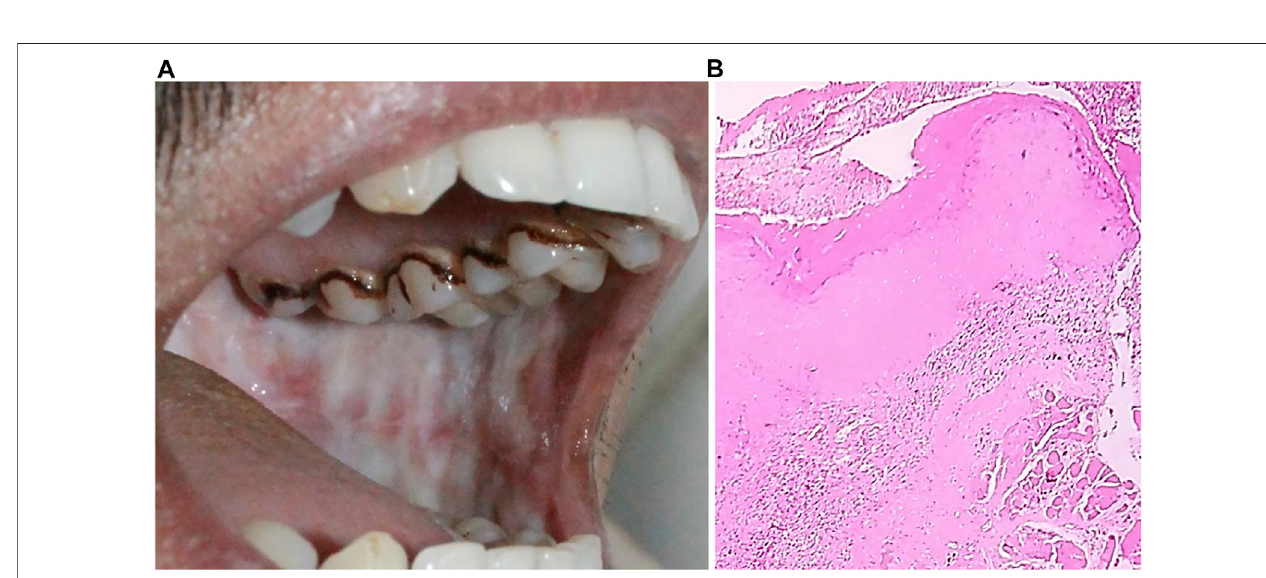
FIGURE 8 | (A) Oral submucosal fi brosis of cheek mucosa. (B) Keratinized strati fi ed squamous epithelium (4x) showing presence of hyalinization and collagenous connective tissue stroma.